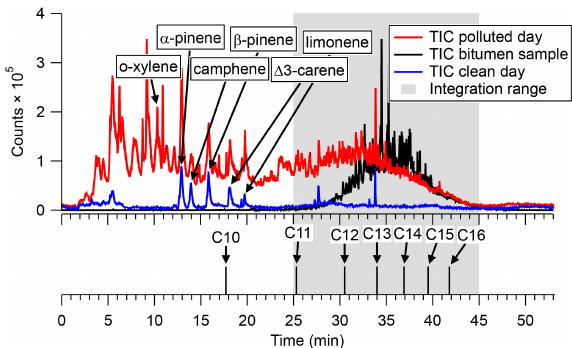
Figure 2. The top shows total ion chromatograms of air samples collected on 27 August 2013 from 18:04 to 18:14UTC (red) and on 28 August 2013 from 13:43 to 13:53UTC (blue). The total ion counts (TICs) of a headspace sample of ground-up bitumen col- lected after the campaign is superimposed (black). The gray area indicates the range over which IVOC signal was integrated. The bottom shows retention times of n -alkanes, determined after the measurement campaign by sampling a VOC mixture containing a C 10 –C 16 n -alkane